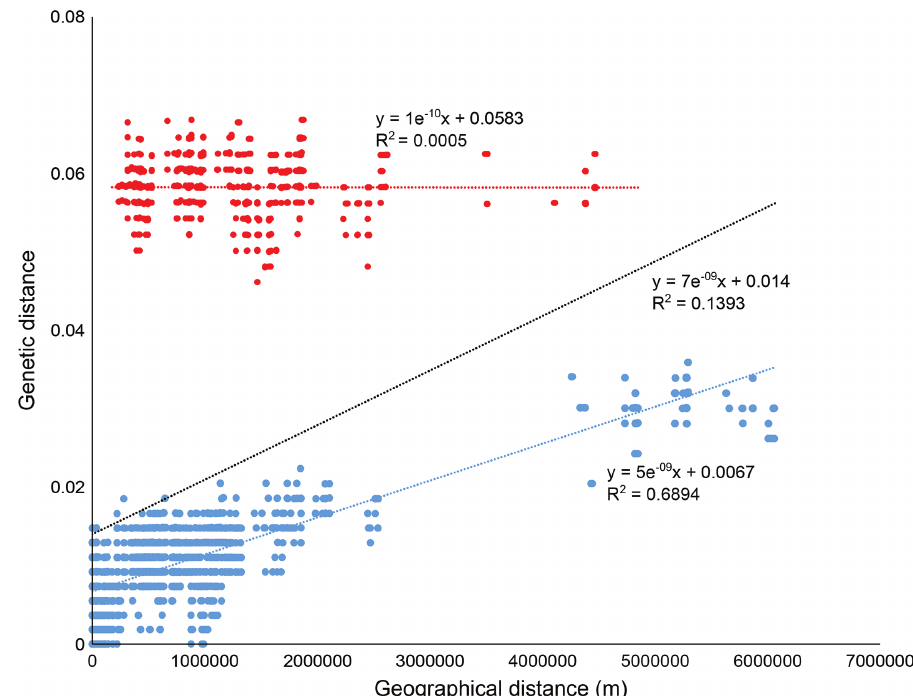
Figure 2. Regression analysis between geographic and genetic distances among all specimens of A. ar- giope s.l. included here. Blue dots and line represent within species comparisons and red dots and line those among the two species as here defined. Black line is regression across all data. Geographical distances well explain genetic distances within species, but not between the species, as